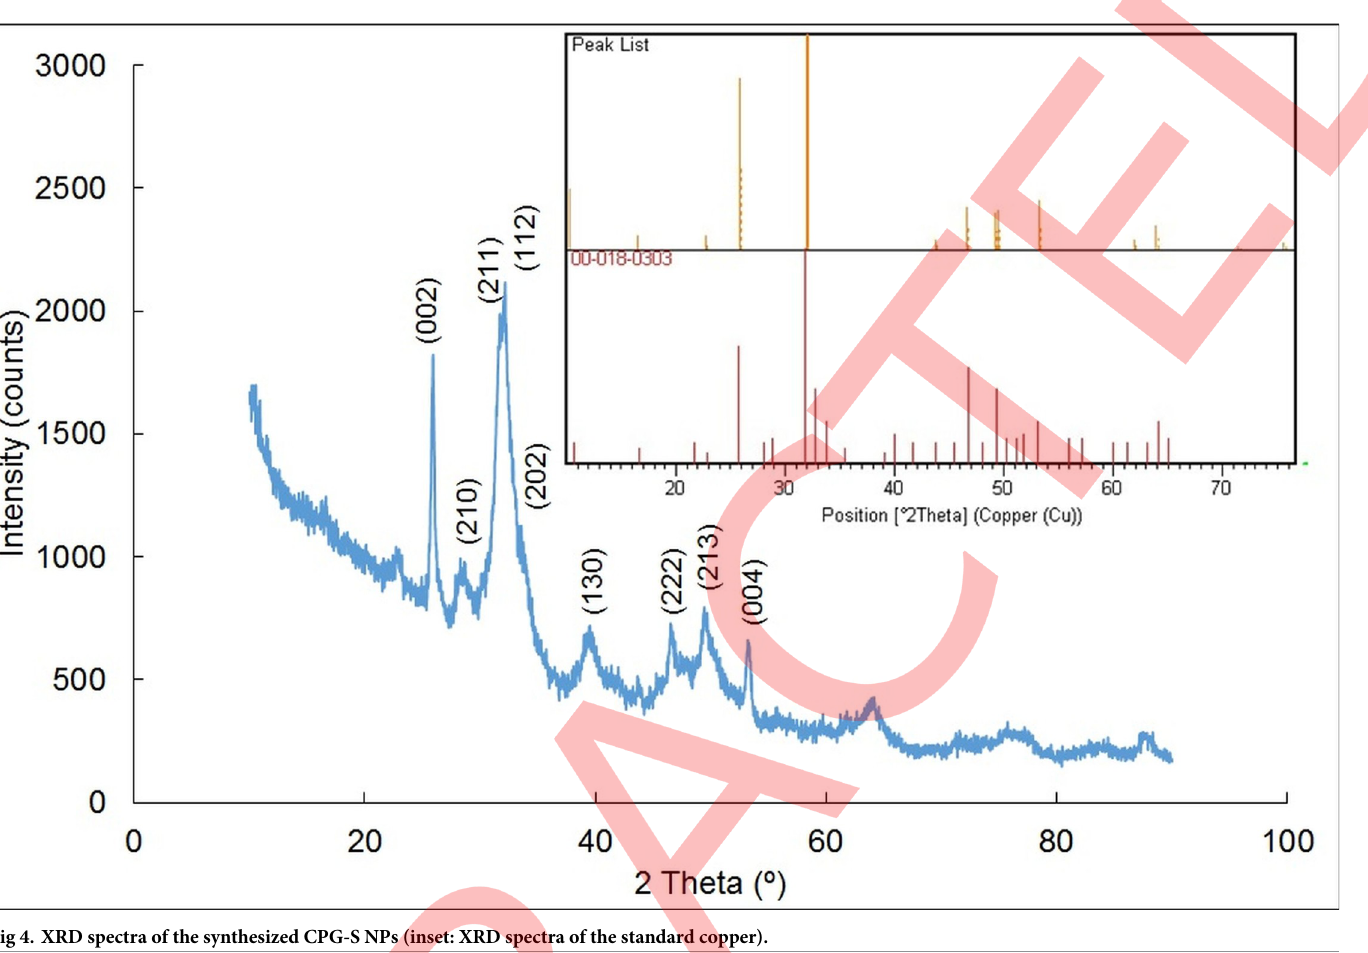
Fig 4. XRD spectra of the synthesized CPG-S NPs (inset: XRD spectra of the standard copper).